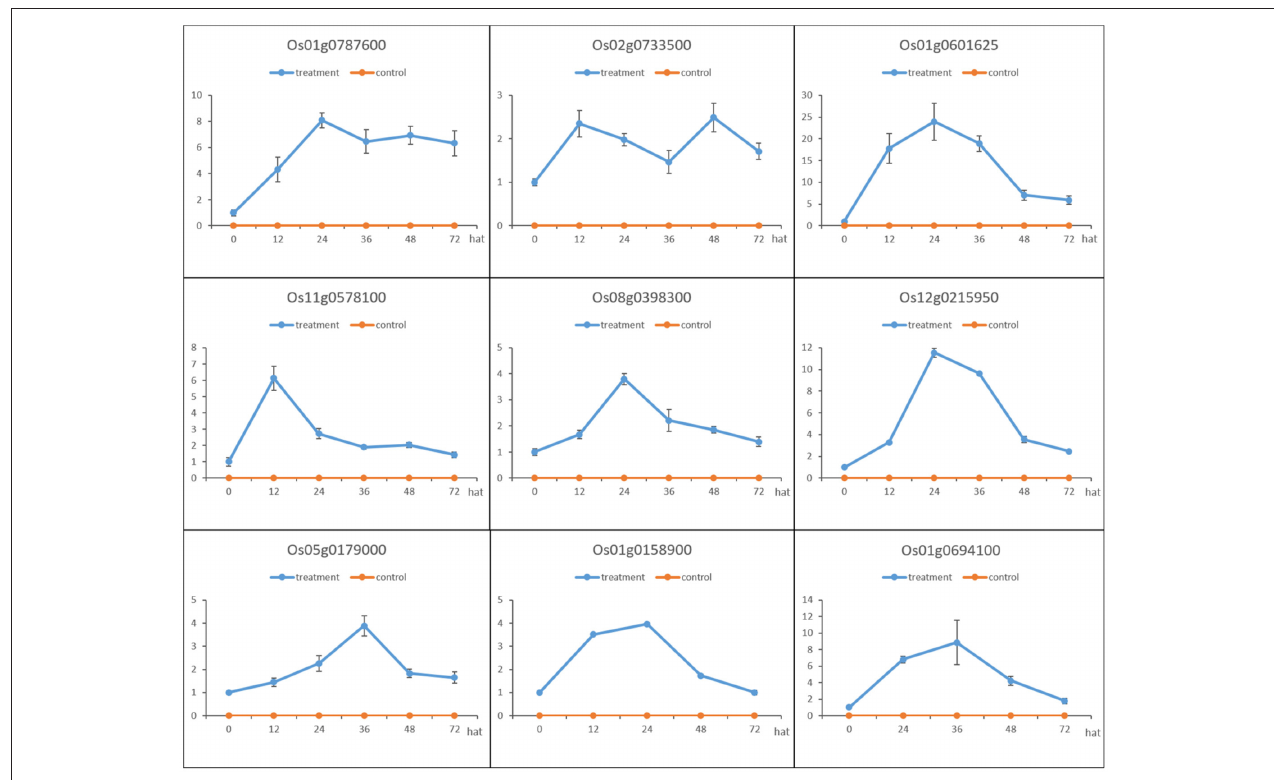
FIGURE 5 | Validation of the DGE results by qRT-PCR of the 9 genes that were up-regulated in the MoHrip1-treated rice but were not expressed in the buffer-treated rice. The expression levels on the y-axis were relative to the non-treated rice (NoT0) after normalization with the β -actin gene. This experiment was repeated three times, and data are presented as the average ± SD with n = 3; hat: h after treatment.